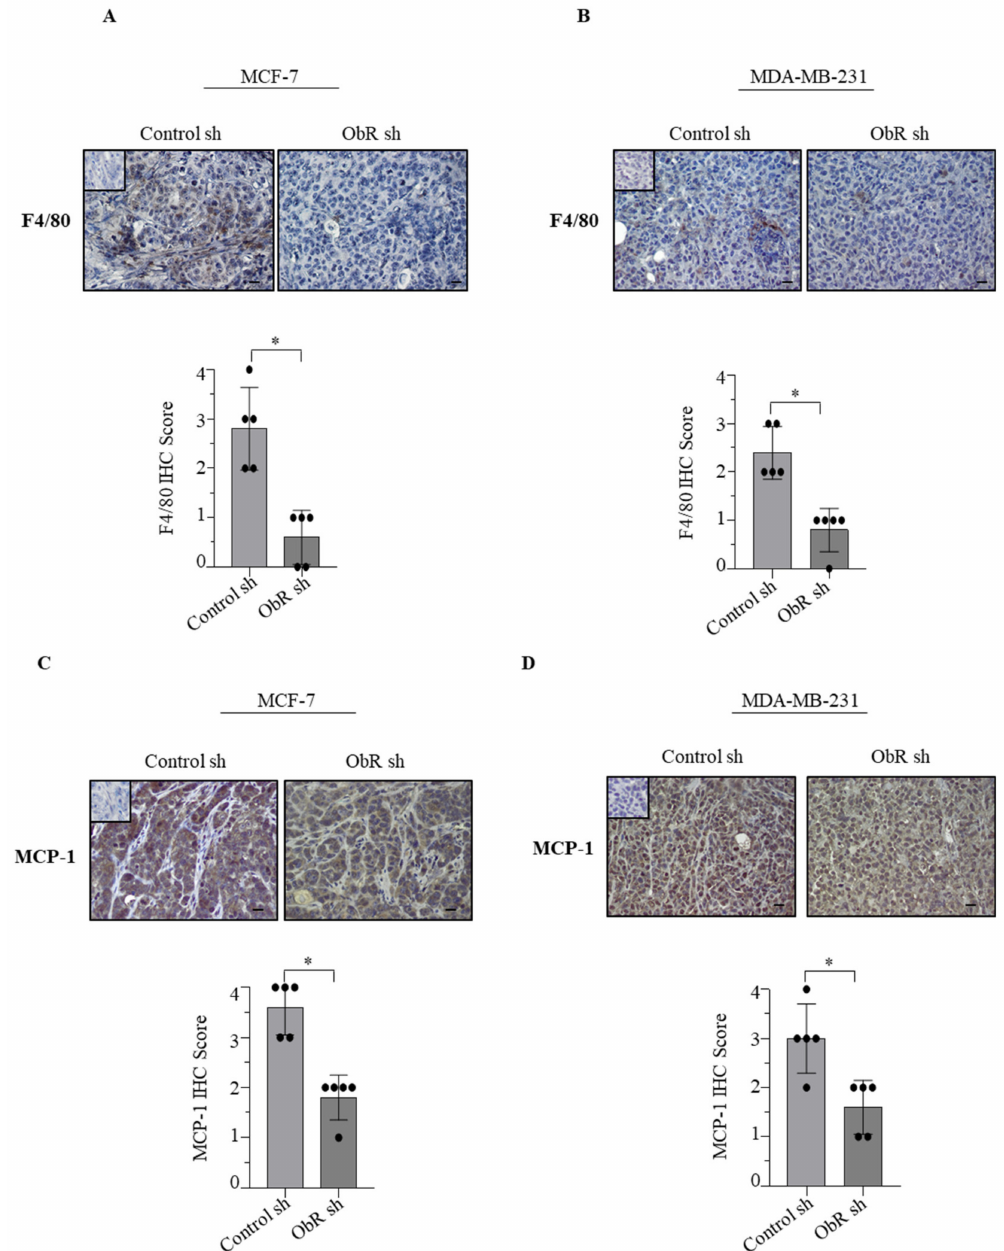
Figure 4. Influence of the lack of ObR on macrophage infiltration and monocyte chemoattractant protein 1 (MCP-1) expression into MCF-7 and MDA-MB-231 xenograft tumors. ( A , B ) Immunohistochemical staining and relative score of F4 / 80 and ( C , D ) MCP-1 in Control sh and ObR sh MCF-7 and MDA-MB-231 xenograft tumor sections. Inset, negative control. Scale bar = 25 µ m. * p < 0.05. The latter finding well fits with the evidence that in both ObR sh clones, MCP-1 was significantly reduced in terms of mRNA expression (Figure 5A,D), protein content (Figure 5B,E) and amount secreted (Figure 5C,F), addressing how an impairment of Ob / ObR signaling may negatively interfere with MCP-1